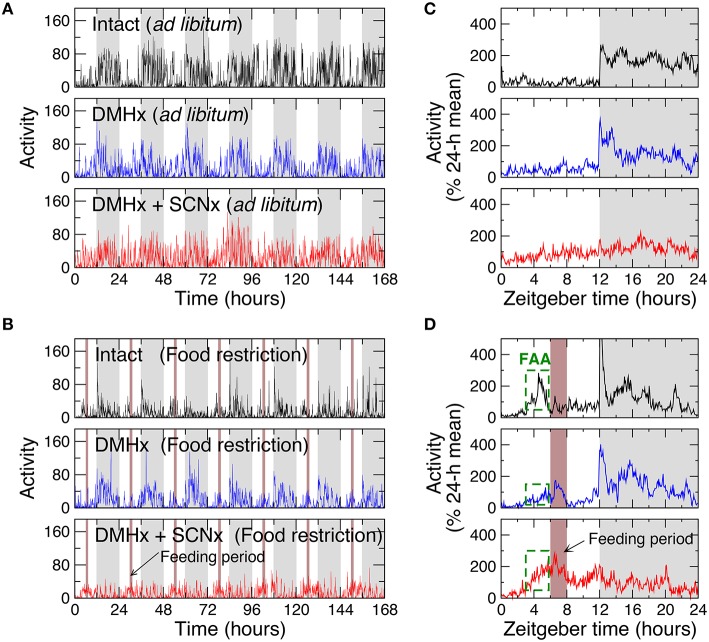
Representative locomotor activity recordings and their averaged daily profiles of rats under 12 h:12 h light-dark cycles. (A) Recordings of an intact rat, a rat with the lesion of DMH (DMHx rat), and the same DMH-lesion rat after an additional lesion of the SCN with ad libitum food access. Gray (white) bars indicate the dark (light) periods of the light-dark cycle. (B) Recordings of an intact rat and a DMHx rat (the same as in A) before and after the SCN lesion with restricted food availability. Food was available daily for 2 h at 6–7 h after light on in each cycle (brown bars). (C) The averaged 24-h activity waveforms of the recordings in (A). (D) The averaged 24-h waveforms of the recordings in (B). To obtain the 24-h activity patterns, data were first normalized by daily means and then averaged across different days. The increased activity levels 3 h before the feeding period (green dashed boxes) indicate food-anticipatory activity (FAA).